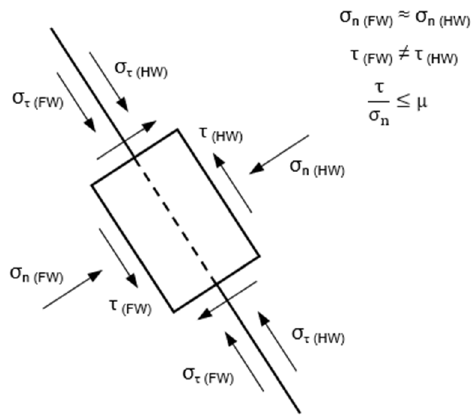
Figure 15. Stress equilibrium condition across a fault surface.